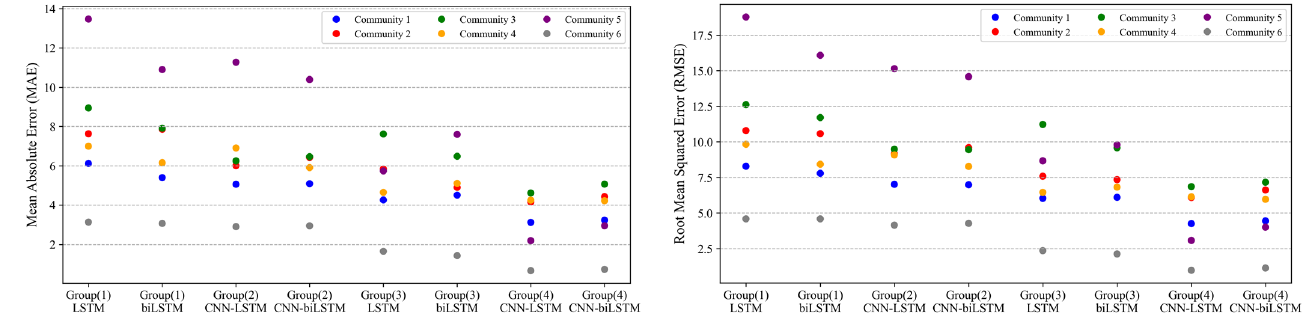
Figure 7. Model performance metrics on test set for individual BIXI community. To comprehend the accuracy of the proposed model visually, the predicted and real values of hourly and daily BIXI trips over test data are shown in Figures 8 and 9 for two selected communities. The percentage error plots are also presented i.e., the